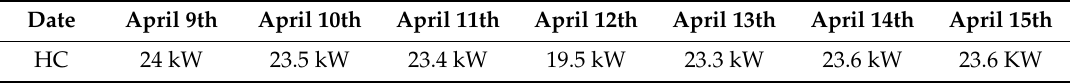
Table 2. Hosting Capacity values for the measured week crossing δ V = 5%.